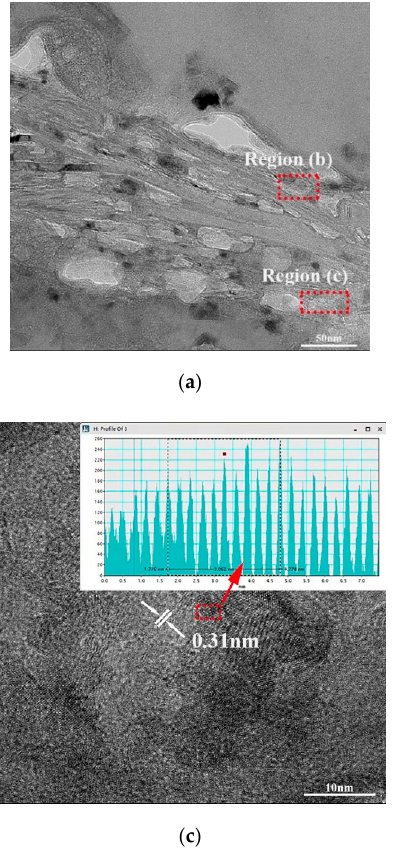
Figure 6. TEM images of CeO 2 -GNPs/2024Al composite: ( a ) high-angle annular dark-field image; ( b , c ) HRTEM image of regions; ( c ) SAED pattern of Region A; ( d ) SAED patterns of region ( c ).